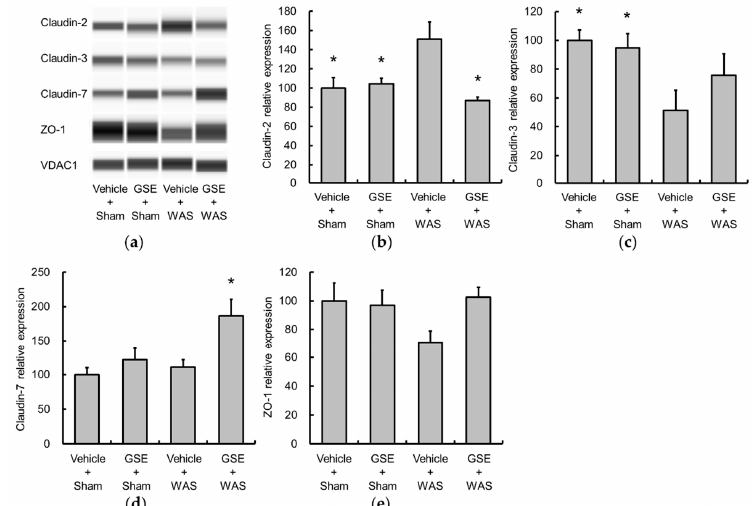
Figure 4. Effects of GSE on WAS-induced changes in tight junction (TJ) protein expression. Colonic TJ protein expression was evaluated using a ProteinSimple Wes system and normalized by VDAC1. Representative images are indicated ( a ). WAS increased claudin-2 ( b ) and reduced claudin-3 ( c ), and GSE prevented the elevation of claudin-2 levels. The expressions of claudin-7 ( d ) and ZO-1 ( e ) were not altered by WAS. Data are presented as the mean ± S.E.M ( n = 6 – 7). * p < 0.05 vs. Vehicle + WAS group. GSE, grape seed extract, TJ, tight junction, VDAC1, Voltage-dependent anion-selective channel 1, WAS, water avoidance stress, ZO-1, zonula occludens-1.